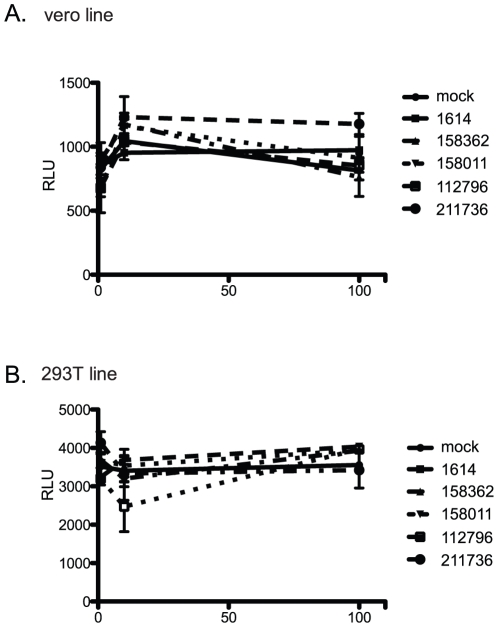
Toxicity assays.VeroE6 (A) or 293T (B) cells were treated with 0, 10 uM or 100 uM of each compound in 1% DMSO for 24 hours. Cells were analyzed for viability with the CellTiter Glo assay (Promega).